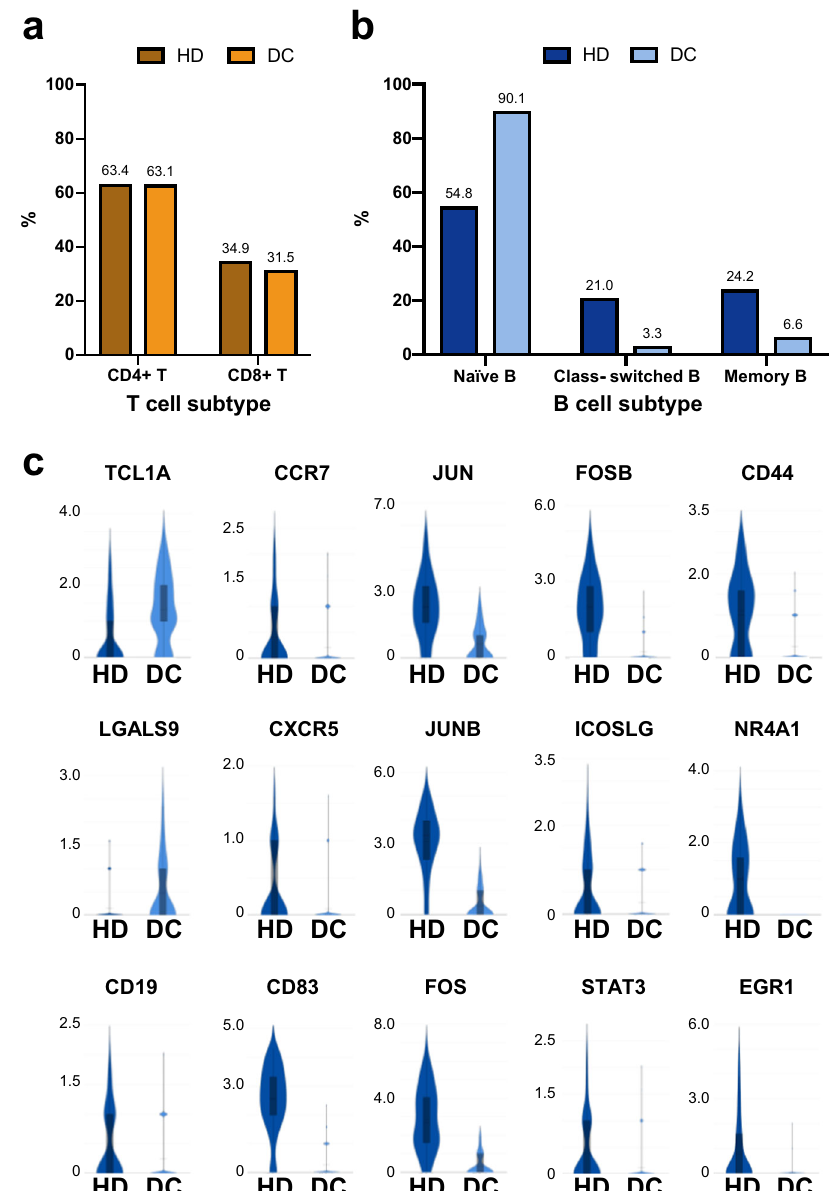
Fig. 4 The DC patient exhibits defects in B-cell function. a Bar graph showing CD4 + T and CD8 + T-cell proportions in the healthy donor and DC patient. b Bar graph showing distinct B-cell subset proportions in the healthy donor and DC patient. c Violin plots showing the differential expression levels of B-cell marker genes in B cells between the healthy donor and DC patient. The box represents the interquartile range; The whiskers represent the rest of the